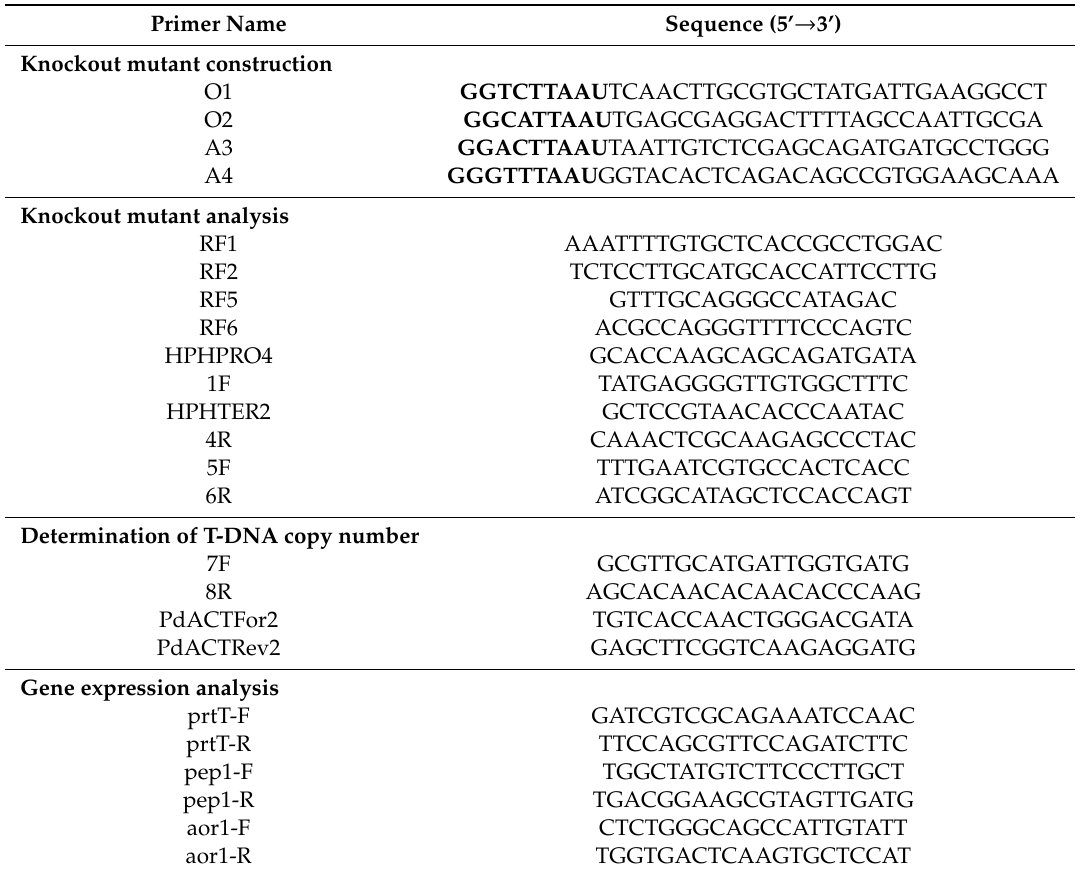
Table 1. Primers used in the study. The 5’ deoxyuridine extension parts in the primers used for the assembly of the USER cloning sites are indicated in